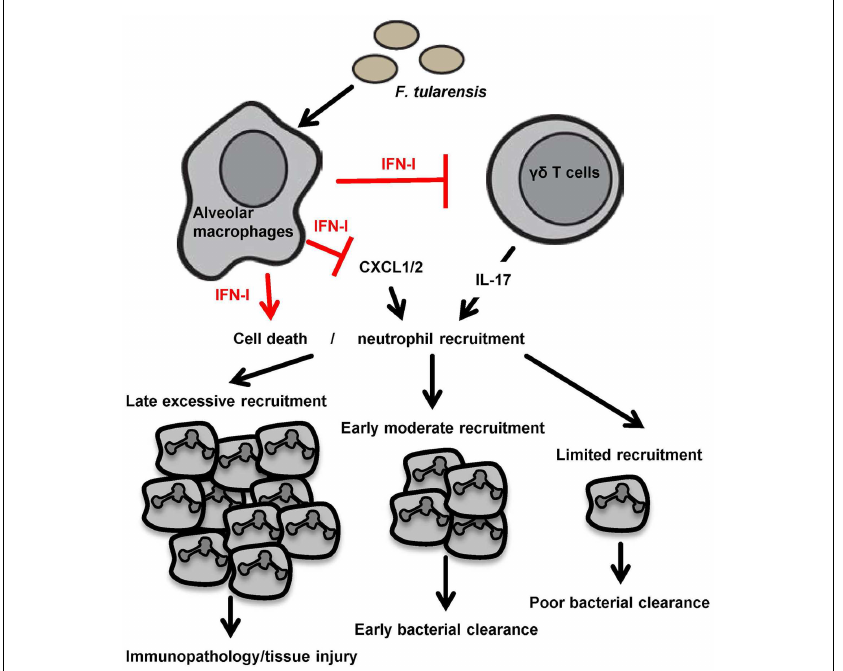
FIGURE 1 |A model depicting the proposed roles of IFN-I and neutrophils during F. tularensis infection is shown. Pulmonary infection with F. tularensis triggers IFN-I production from innate immune cells such as alveolar macrophages. IFN-I may sensitize F. tularensis -infected neutrophils for cell death and contribute to an overall reduction in neutrophil numbers at the site of infection. IFN-I may also directly limit neutrophil recruitment via inhibition of IL-17 producing γδ T cells or suppression of other neutrophil chemoattractants. Suppression of neutrophil recruitment may prevent tissue damage associated with excessive infiltration of neutrophils as well as lead to inadequate bacterial clearance, resulting in an unfavorable outcome. An optimal neutrophil response may require moderate recruitment at an early time point to aid in prompt clearance of bacteria without causing significant inflammation later during pulmonary